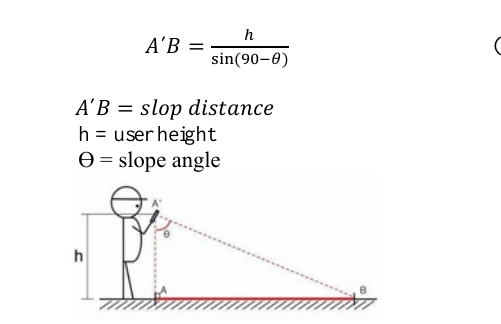
Figure 2. Triangle method: AA´B is the target triangle.